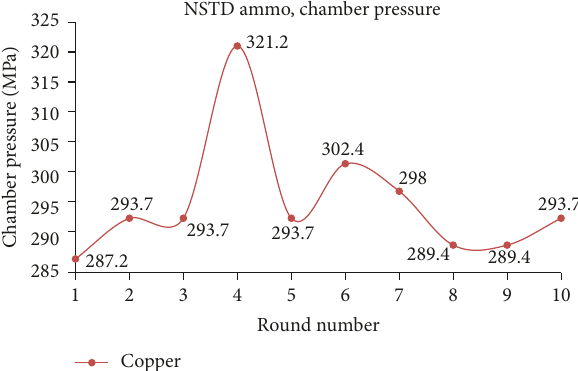
Figure 24: Chamber pressure measured with copper crusher using NSTD